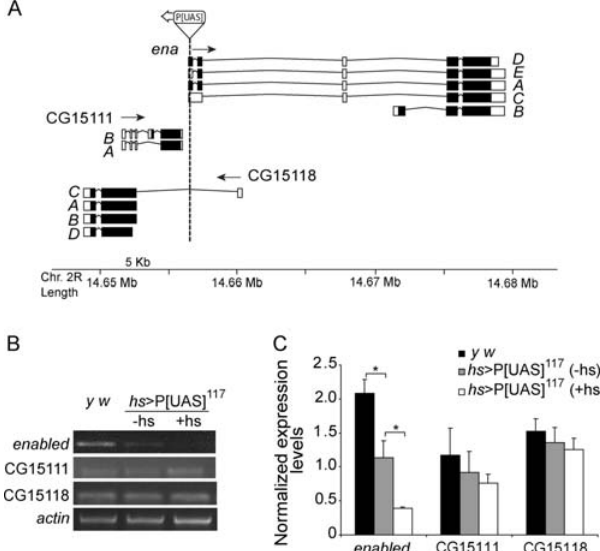
Figure 3. Plasmid rescue and RT-PCR analysis identifies ena as the affected locus. (A) Schematic diagram depicting the position of the P[UAS] transposon within the DNA region trapped by the insertion (to scale, in kb). The P[UAS] 117 is located within the first exon of ena upstream of the ATG. It also landed within the first intron of CG15118 and near CG15111. Arrows indicate the direction of transcription for each gene. A–E refers to the different splicing variants in each locus. (B) To test the GAL4 mediated effect on each locus an ubiquitous heat shock ( hs ) GAL4 driver was employed. RT-PCR analysis was performed in hs . P[UAS] 117 total larval RNA after a heat-shock stimulus ( + hs). A non- pulsed control was used as baseline (-hs) along with a wild type control ( y w ). Semi quantitative RT-PCR products were analyzed on agarose gels stained with ethidium bromide (the image reflects ena levels at cycle 28). actin levels were compared for quality control of the independent RNA preparations and normalization. (C) The ratio between each independent gene to actin levels highlights significant changes only in the ena locus (* p , 0.05). The insertion per se significantly reduces ena levels (* p , 0.05). Statistical analysis included a Student t test. The experiment was repeated 3–4 times using independent RNA prepara-